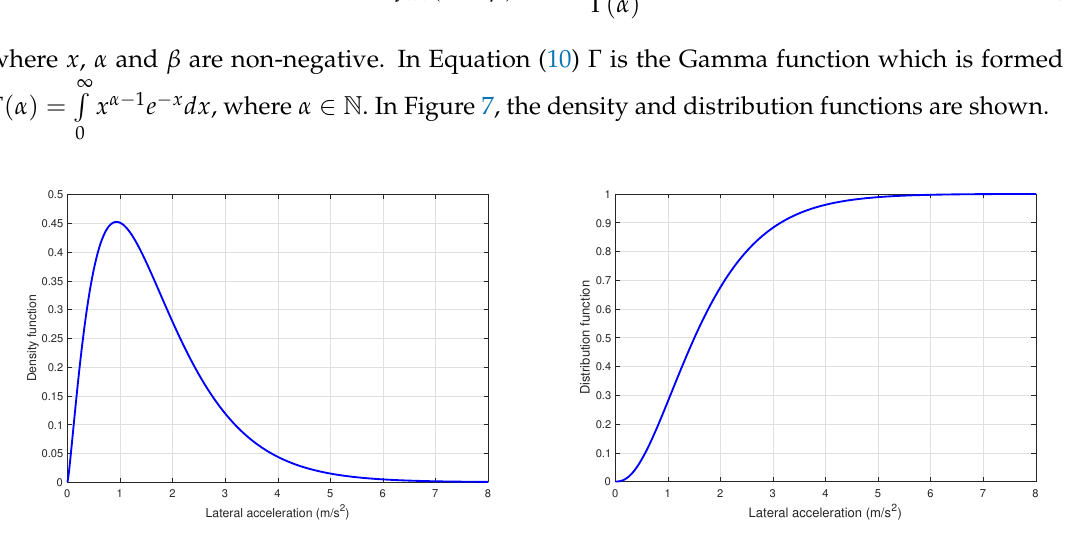
Figure 7. Density and distribution function of the lateral